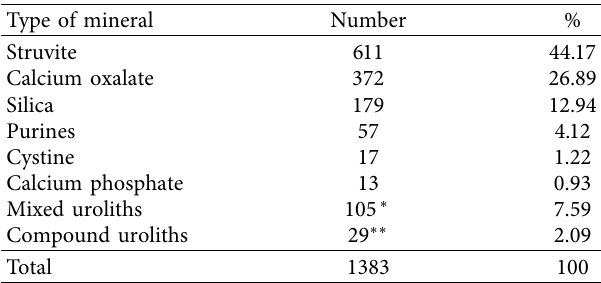
Table 1: Mineral composition of uroliths from dogs between 2005 and